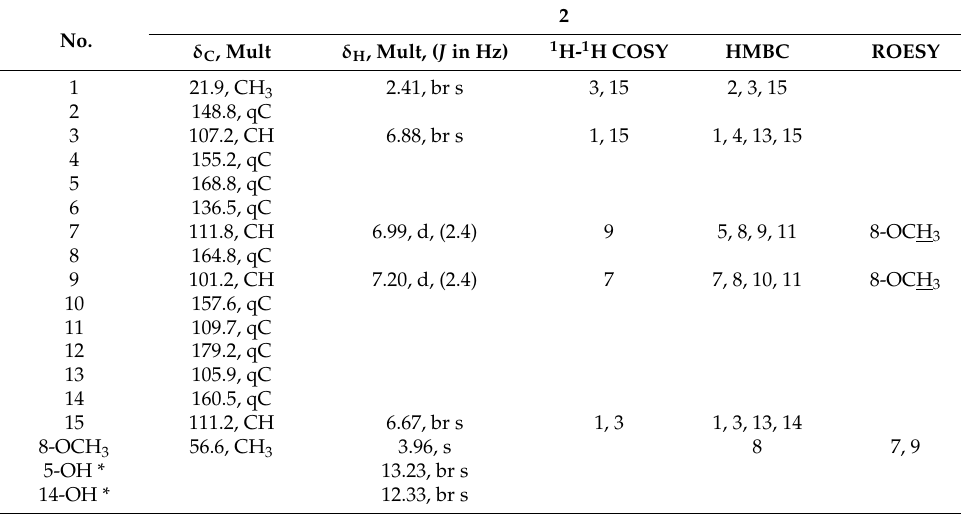
*: The assignment maybe exchanged.